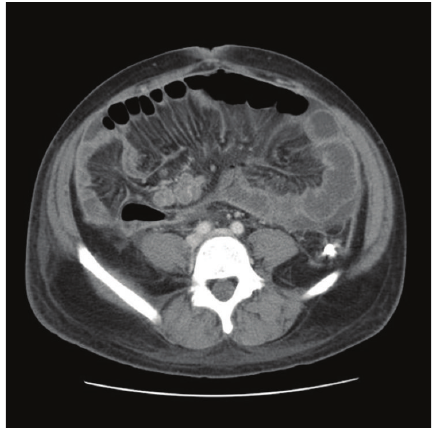
Figure 1: CT abdomen and pelvis revealing enlarged mesenteric lymph nodes and prominent retroperitoneal lymph nodes along with omental infiltration.